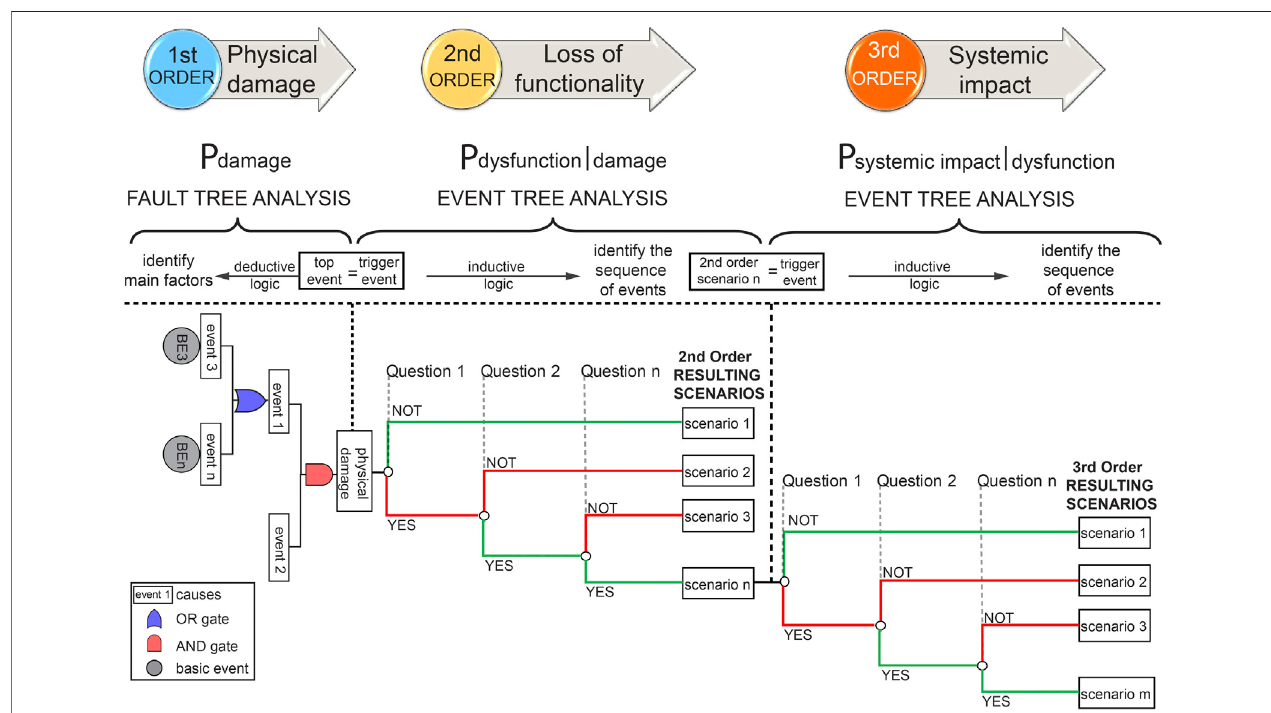
FIGURE 3 | Theoretical bow-tie structure of this framework connecting fi rst, second and third order of impacts. First order of impact is described by a fault tree whose top event serves as trigger event of an event tree describing the second order of impact. Each of the resulting scenarios of this event tree represents the trigger event of subsequent event trees describing the third order of